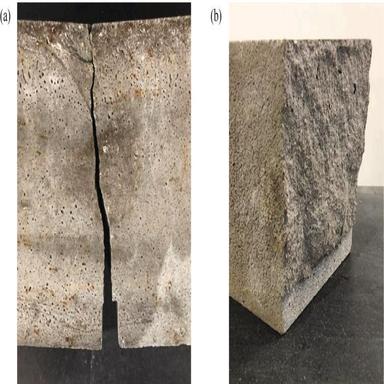
Mortar M2 after three-point bend tests: (a) typical crack patterns; (b); details of collapse surface.